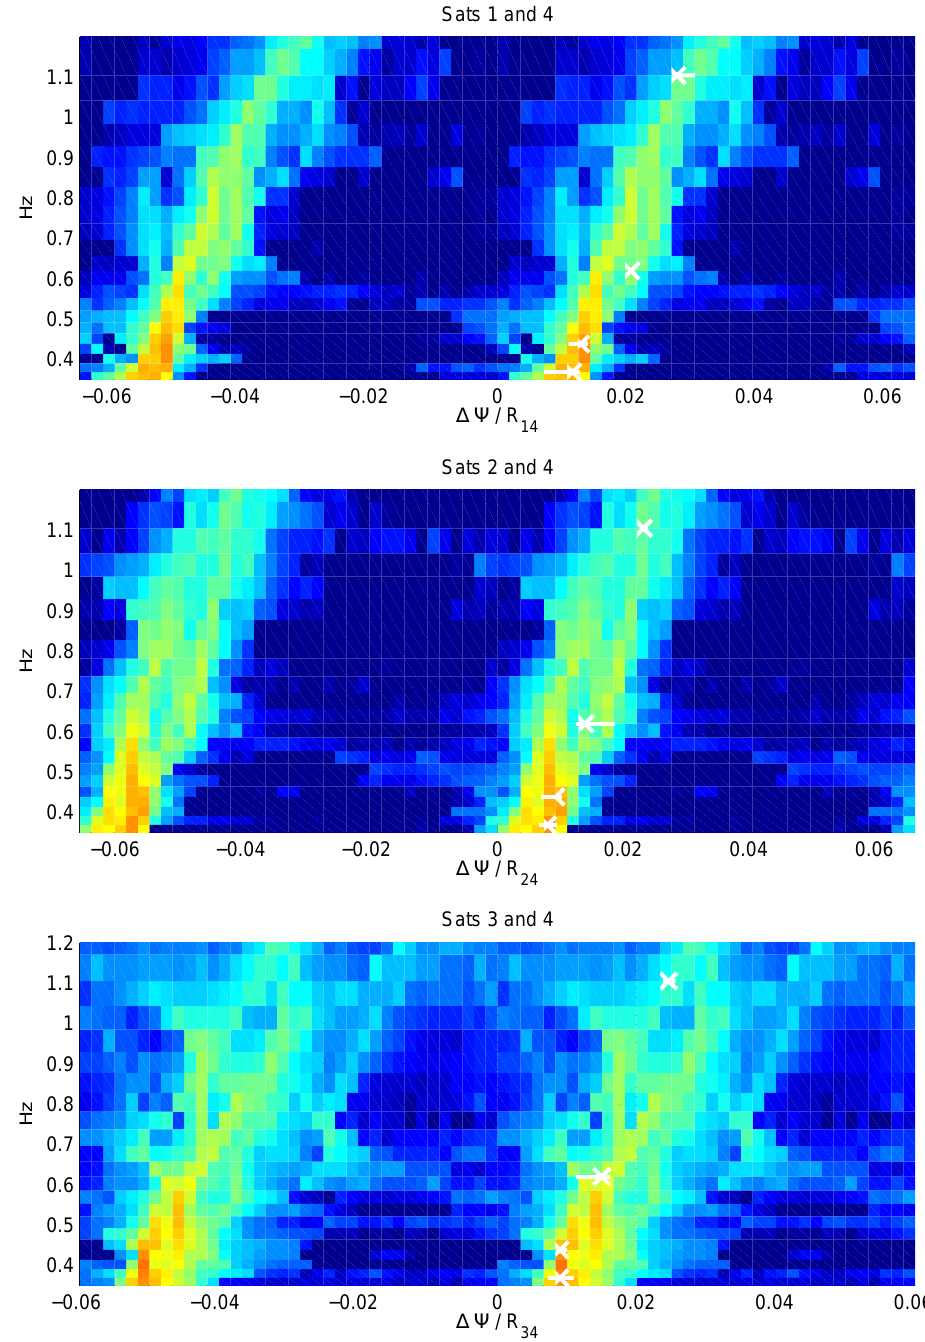
Fig. 3. The ω − k joint spectrogram computed using STAFF SC data for satellite pairs 14, 24, and